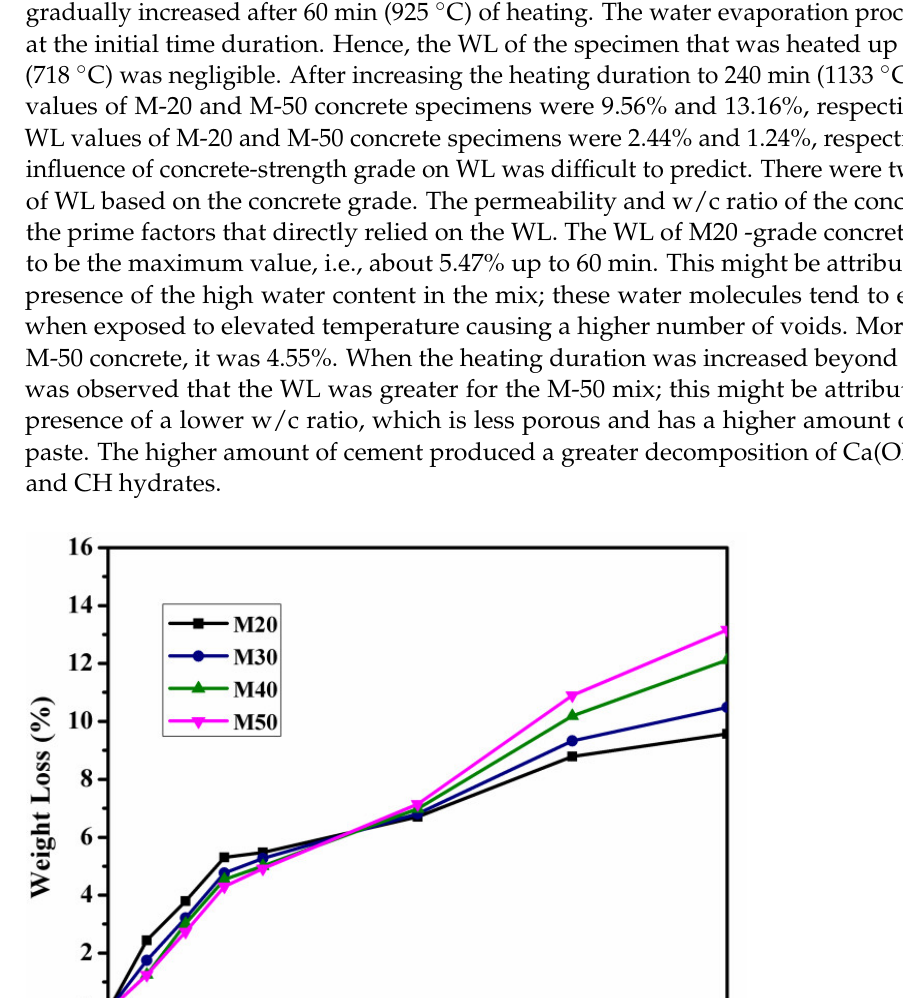
Figure 10. Surface change in concrete specimens exposed to elevated temperatures.